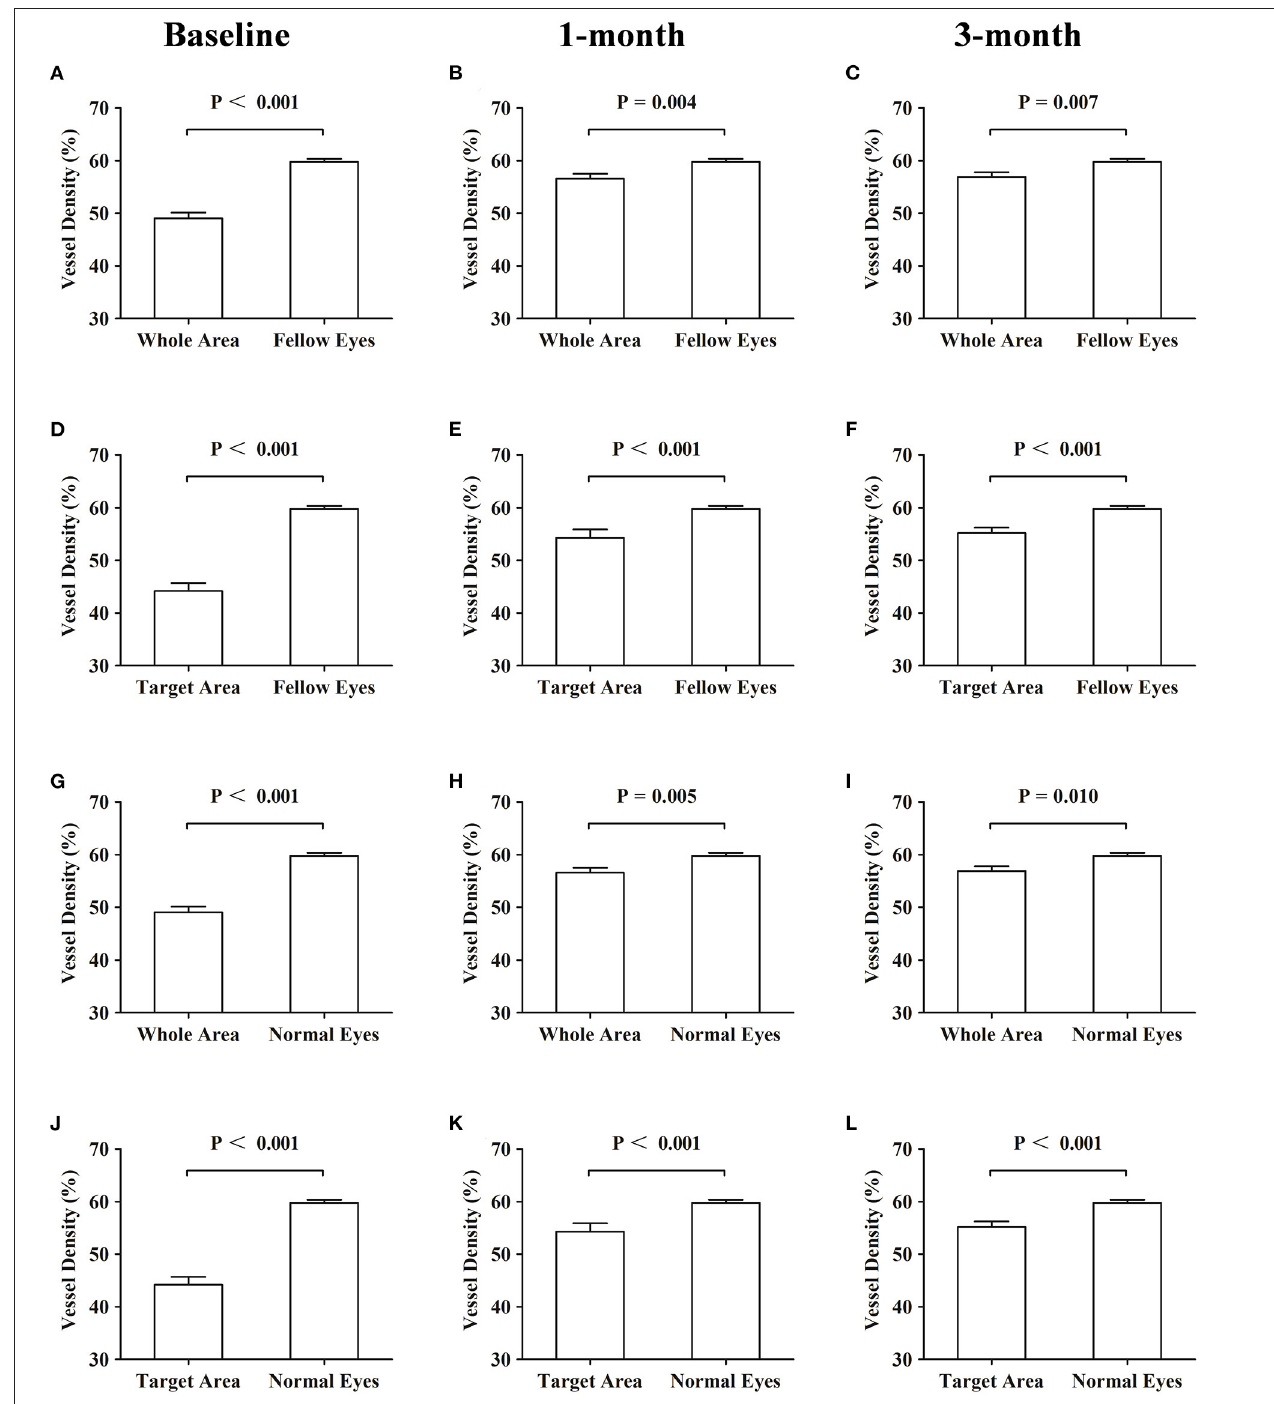
FIGURE 4 | Comparisons of the vessel density of the superficial choroidal layers at baseline and at 1 and 3 months. Comparisons of the vessel density of the superficial choroidal layers. (A–C) Whole area vs. fellow eyes. (D–F) Target area vs. fellow eyes. (G–I) Whole area vs . normal eyes. (J–L) Target area vs. normal eyes.